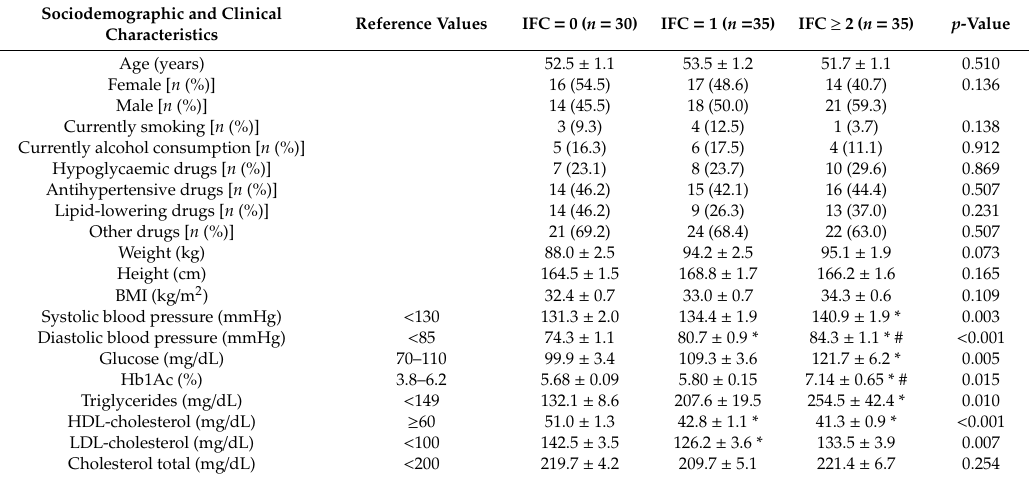
Table 1. Characteristics of participants with nonalcoholic fatty liver disease (NAFLD) according to the intrahepatic fat content